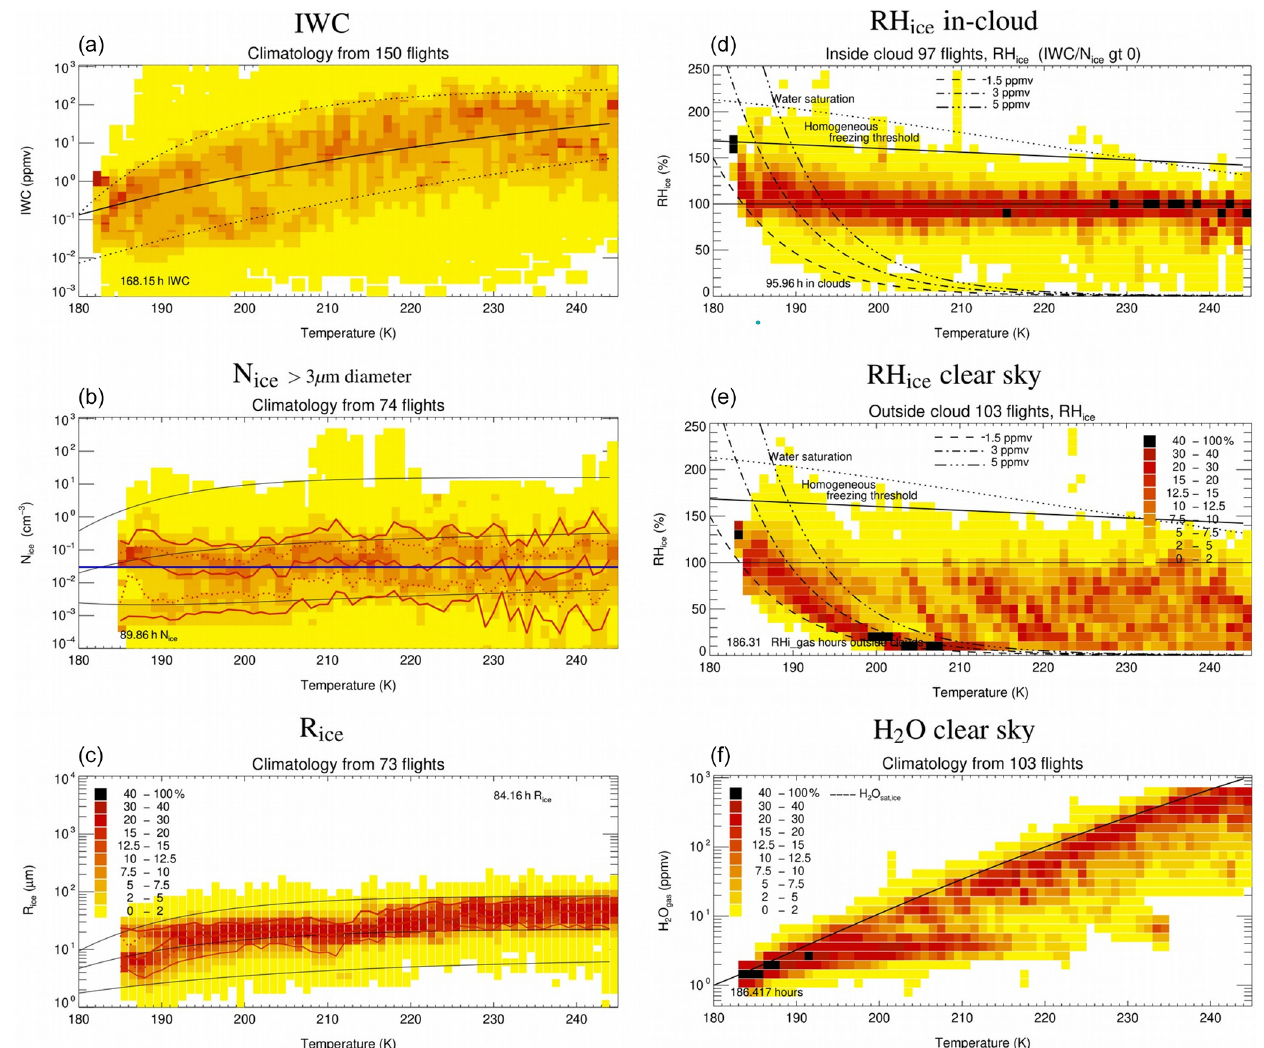
Figure 7. Frequencies of occurrence in dependence on temperature, binned in 1K intervals of ice water content (IWC; a ; black solid and dotted lines: median, min, and max IWC of the core IWC band of Schiller et al., 2008). Ice crystal number ( N ice , size > 3µm diameter, b ; red lines: 10th, 25th, 50th, 75th, and 90th N ice percentiles; blue line: fit through median N ice values (median N ice : 0.03cm − 3 ; 10th, 25th, 75th, and 90th percentiles: 0.002, 0.007, 0.102, 0.3cm − 3 ); black lines: minimum, middle, and maximum N ice of Krämer et al., 2009). Mass mean radius ( R ice : calculated from IWC and N ice , c ; red lines: 10th, 25th, 50th, 75th, 90th R ice percentiles; black lines: minimum, middle, and maximum R ice of Krämer et al., 2009). In-cloud and clear-sky relative humidity with respect to ice (RH ice , d , e ), and water vapor volume mixing ratio (H 2 O, f ). The field campaigns included in the data analysis are listed in Table A2. Data evaluation methods and detection ranges of the parameters are described in Appendix A. Note that for N ice – and thus R ice – the hours spent in clouds is less than in Fig. 3. The reason is that for the calculation of data frequency distributions only measurements covering the same detection range are used (see also Appendix